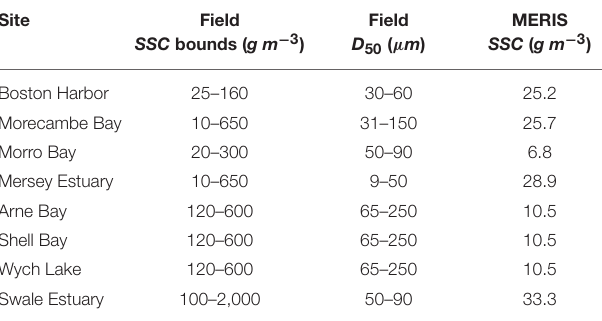
TABLE 3 | Sediment conditions used for the production of Figures 6 , 7